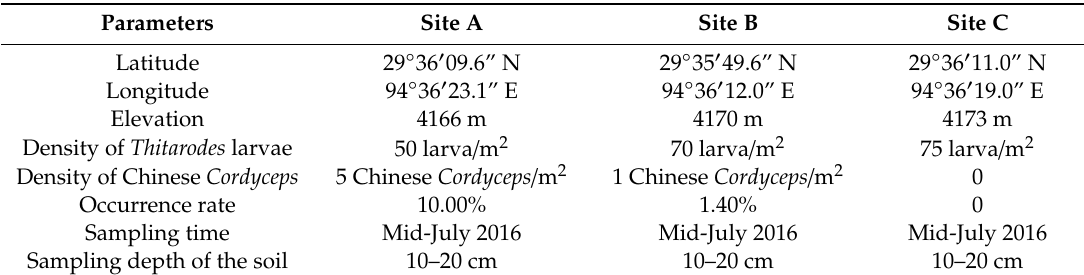
Table 1. Information of sampling in this